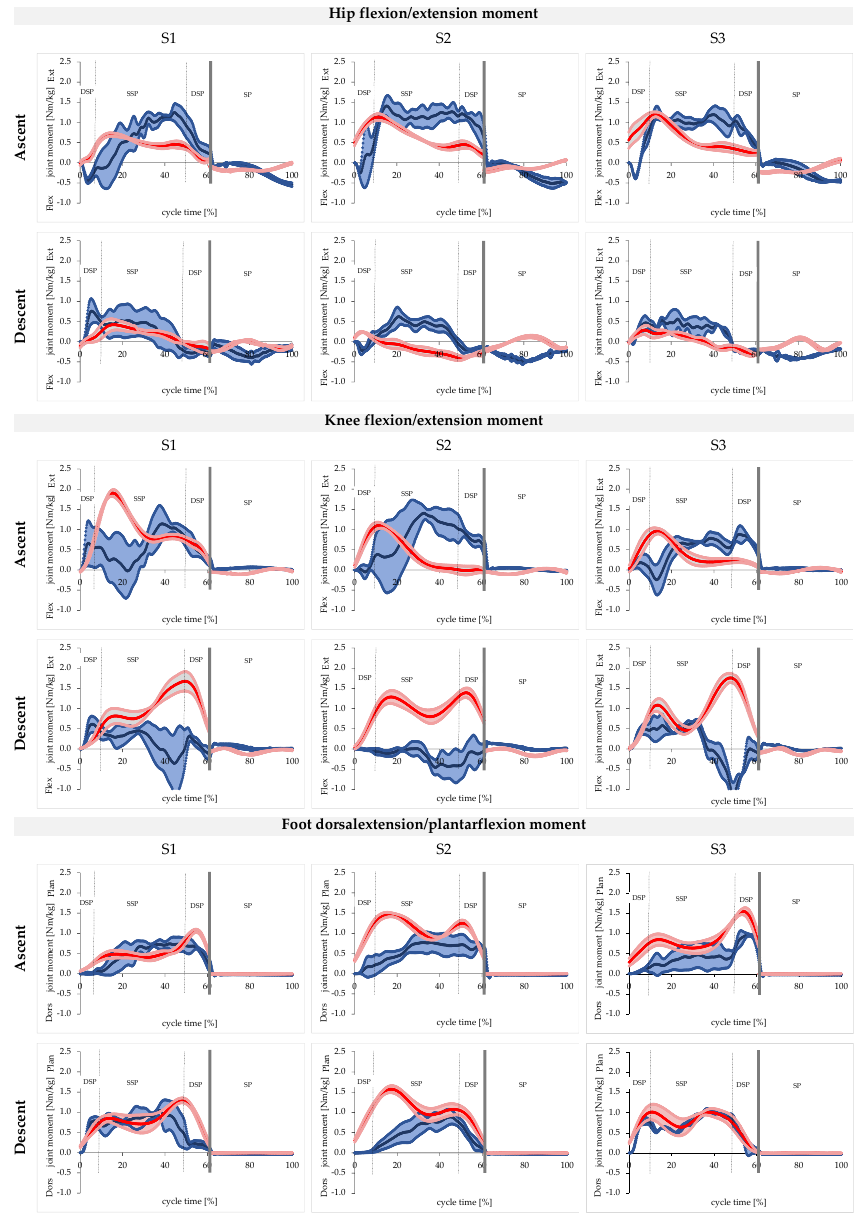
Figure 8. Foot, knee, and hip moment curves in the sagittal plane for ascent and descent without (red) and with (blue) the exoskeleton for Subject 1 ( left ), Subject 2 ( middle ), and Subject 3 ( right ); DSP = double stance phase, SSP = single stance phase, SP = swing